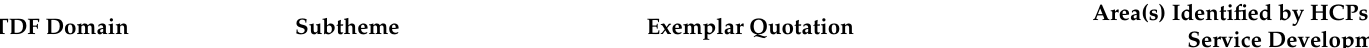
Table 2. Healthcare professionals’ quotations for emergent domains and subthemes on application and integration (assessment/discussion/prescription) of physical activity in routine